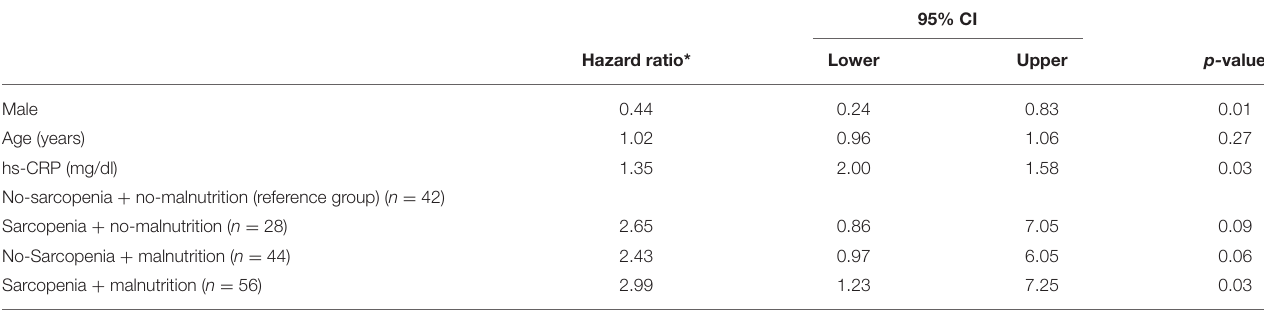
TABLE 4 | Risk for mortality events, expressed as hazard ratio* according to the combination of group with sarcopenia and malnutrition in older adults undergoing maintenance hemodialysis ( n = 170).